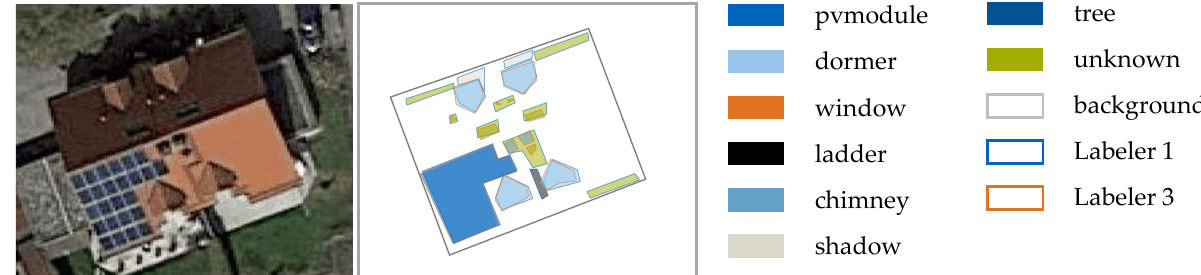
Figure 5. Exemplary visualization of annotations of the annotators (blue edge) 1 and 3 (orange edge). Union is depicted by the higher alpha value of the colors.